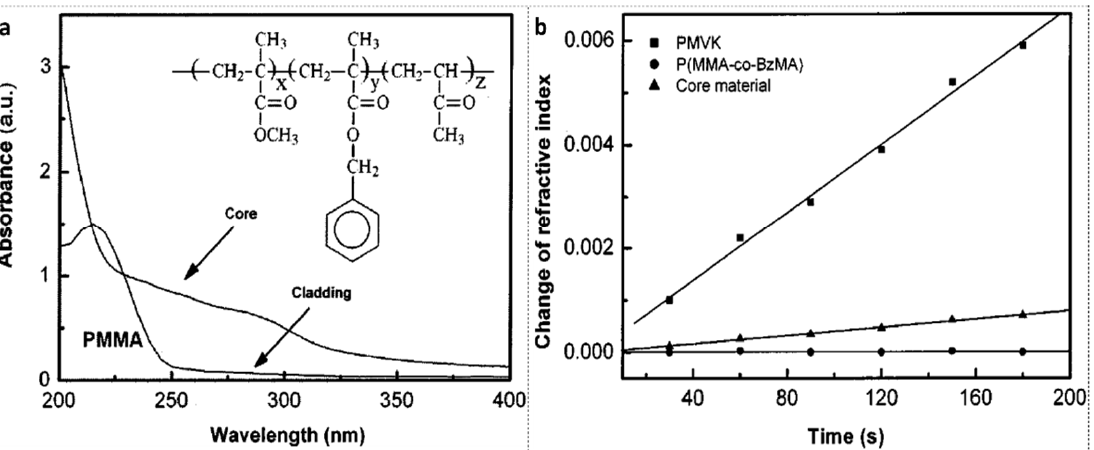
Figure 6. ( a ) Spectra of core material [P(MMA ‐ co ‐ MVK ‐ co ‐ BzMA)] and cladding material PMMA; Inset: chemical structure of core material. Reprinted with permission from [16]. ( b ) Refractive index changes of PMVK, P(MMA ‐ co ‐ BzMA) and core material under UV (wavelength over 300 nm) irradiation as a function of time. Reprinted with permission from [16].